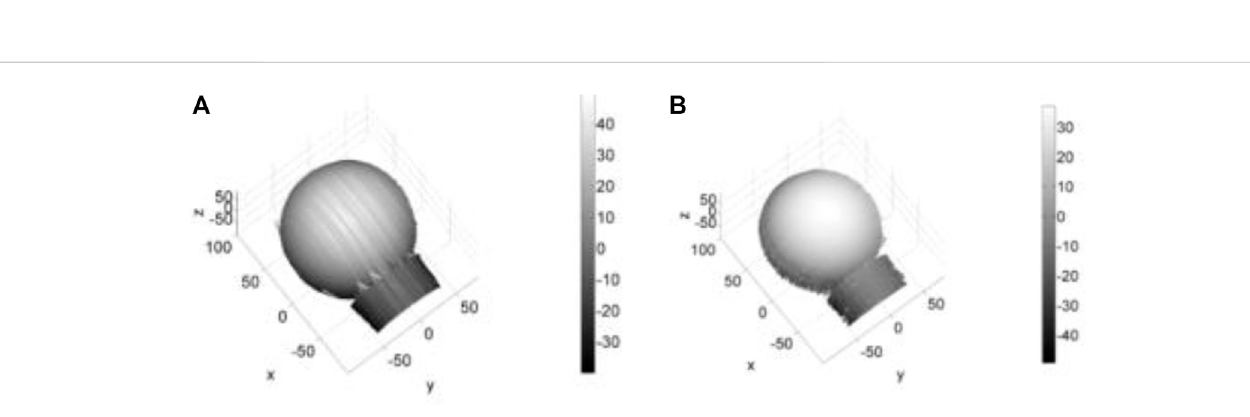
FIGURE 11 Spherical Reconstructed Image. (A) The method of combining Intersection method and Gray Gravity method; and (B) This article